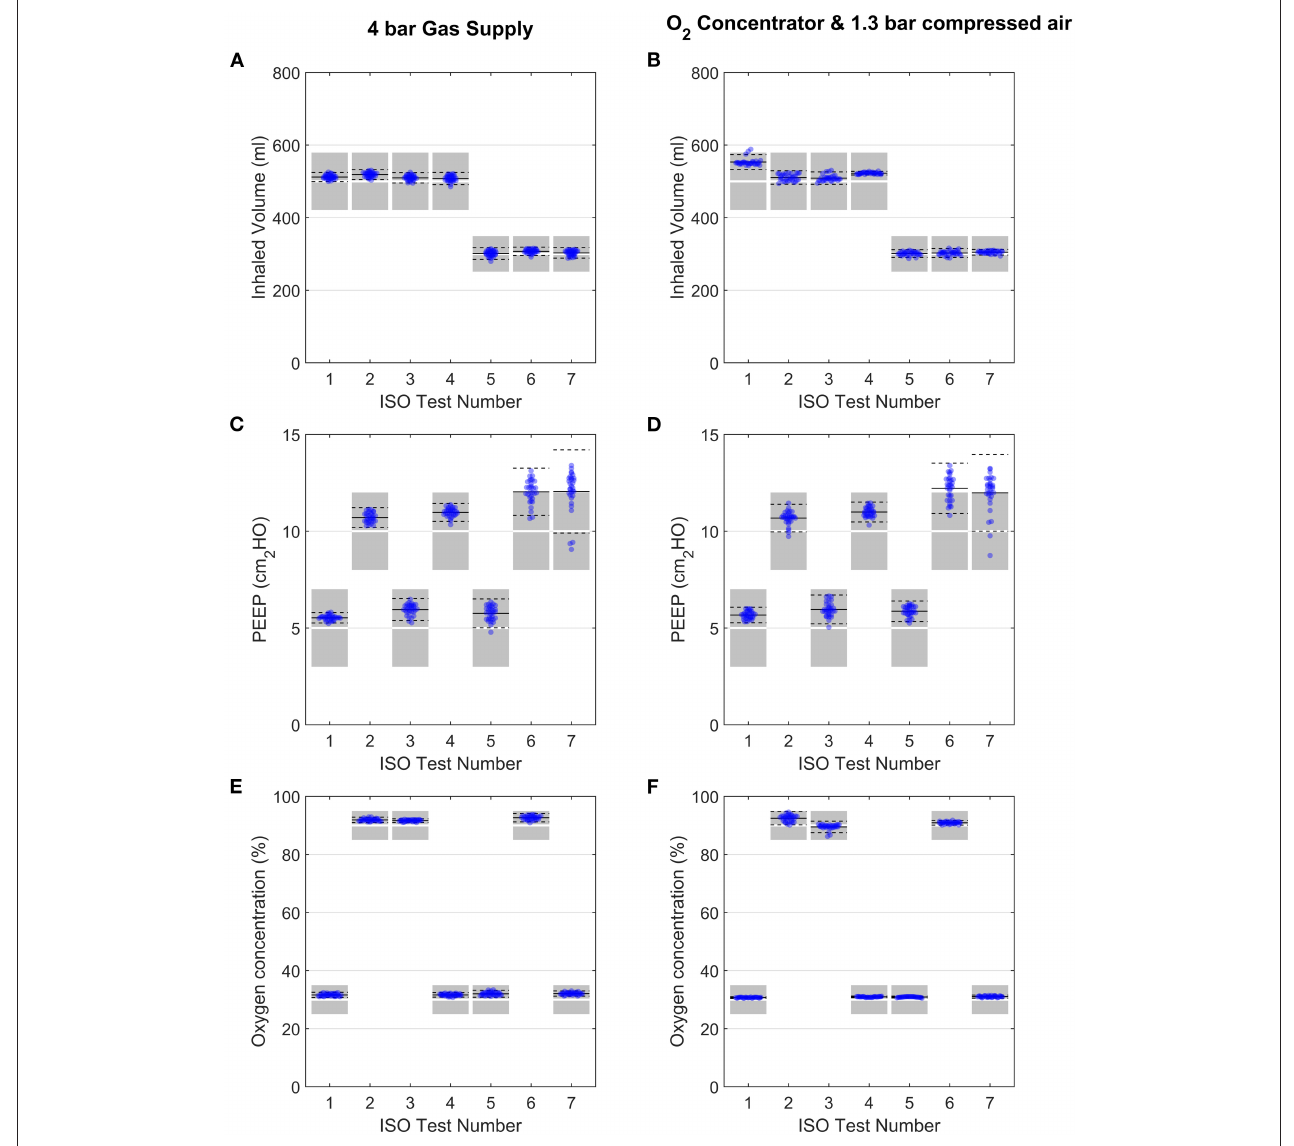
FIGURE 7 | Evaluation of performance under the ISO 80601-2-12:2020 testing schedule ( Table 2 ). Variation in inhaled volume, PEEP and oxygen concentration are shown for each ISO test, when used with 4-bar gas supplies (A–C) or an oxygen concentrator (D–F) . Each data point represents for 1 breath, with 31 breaths shown for each test. Data points shown are from breaths 4 to 36 (exclusive). In all panels, solid black lines and dashed black lines represent the average and ± 2SD of all datapoints. Shaded regions in panels (A,B,E,F) represent ISO 80601-2-12:2020 acceptable margins of uncertainty [ ± (4ml + 15% of the measured value) for volume and ± 5% for oxygen concentration], while those in panel (C) and (D) represent the ISO 80601-2-12:2020 acceptable uncertainty in PEEP pressure measurement ( ± 2 cmH 2